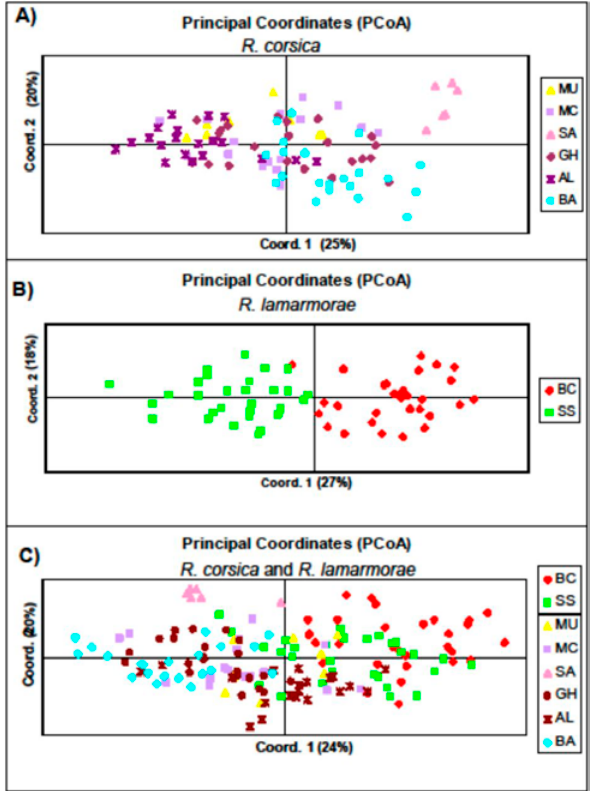
Figure 3. Principal Coordinate Analysis (PCoA) based on the mul- tilocus genotypes of 96 individuals of R. corsica (A), 60 individu- als of R. lamarmorae (B), and the two species together (C). The percentage of the total variability explained by the first two com- ponents is indicated on brackets. Each symbol represents a single plant from one of the eight studied populations. Information on each population is provided in Table 1.